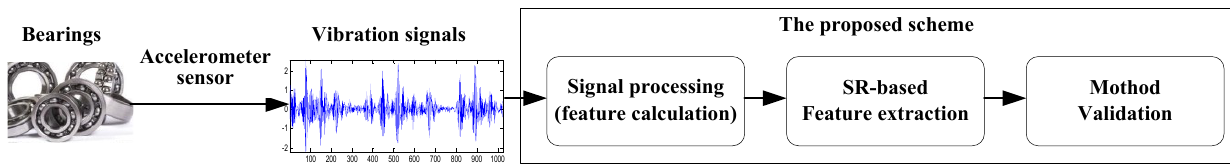
Figure 2. The flow chart of the proposed scheme.